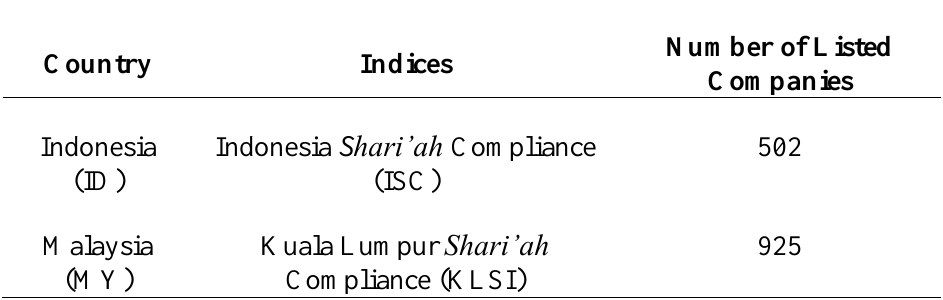
Table 2. Selected Countries for Return Behavior